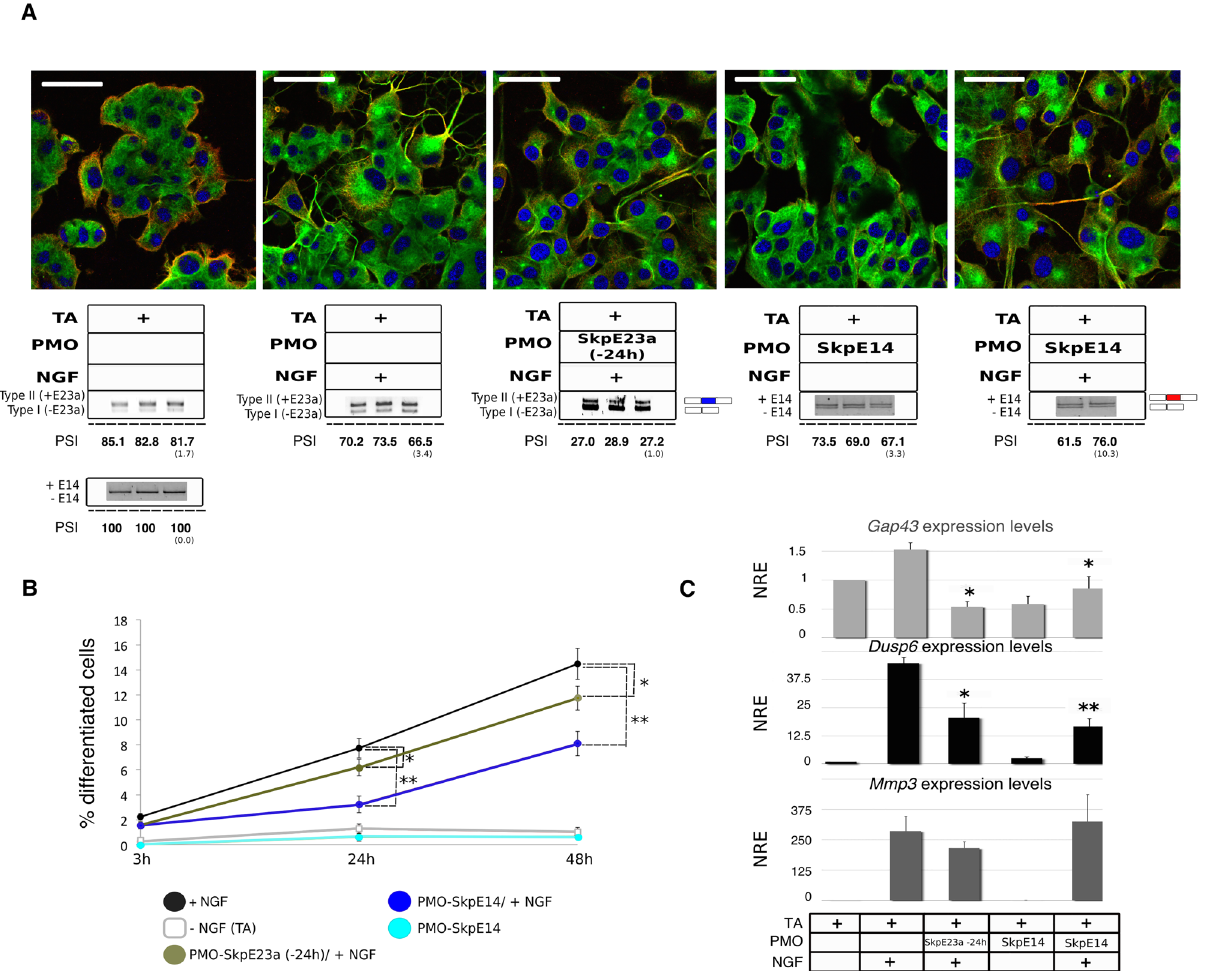
Figure 7. Impact of inducing NF1 isoform switch before NGF-triggered differentiation of PC12 cells. ( A ) Top: Representative images of a double immunofluorescence staining of NGFR (red) and α-tubulin (green) of PC12 cells after 48 h at different experimental conditions (scale bar = 62 μm). Bottom: Box specifying the different experimental conditions and either the type II/I isoform expression ratio or the levels of E14 skipping measured by RT-PCR. For detection of E14 skipping, cells were treated with puromycin. E23a and E14 splicing was quantified as the percent spliced-in (PSI) (standard deviation in parentheses). Supporting whole gel images can be found in Supplementary Fig. S10. ( B ) Time course analysis of the percentage of differentiated cells per field for each experimental condition. Each point represents the Mean ± SEM. * P < 0.05, ** P < 0.01, paired t -test versus cells treated only with NGF. ( C ) Expression of neuronal differentiation markers Dusp6 , Gap43 , Mmp3 at different experimental conditions, analyzed by RT-qPCR. NRE: Normalized Relative Expression ( Rpl29 and Rpl19 were used as reference genes). Bars indicate Mean ± SEM. * P < 0.05, ** P < 0.01, paired t -test versus cells treated only with NGF. TA: Transfection